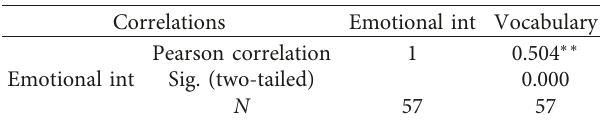
Table 6: The relationship between emotional intelligence and vocabulary knowledge of English.